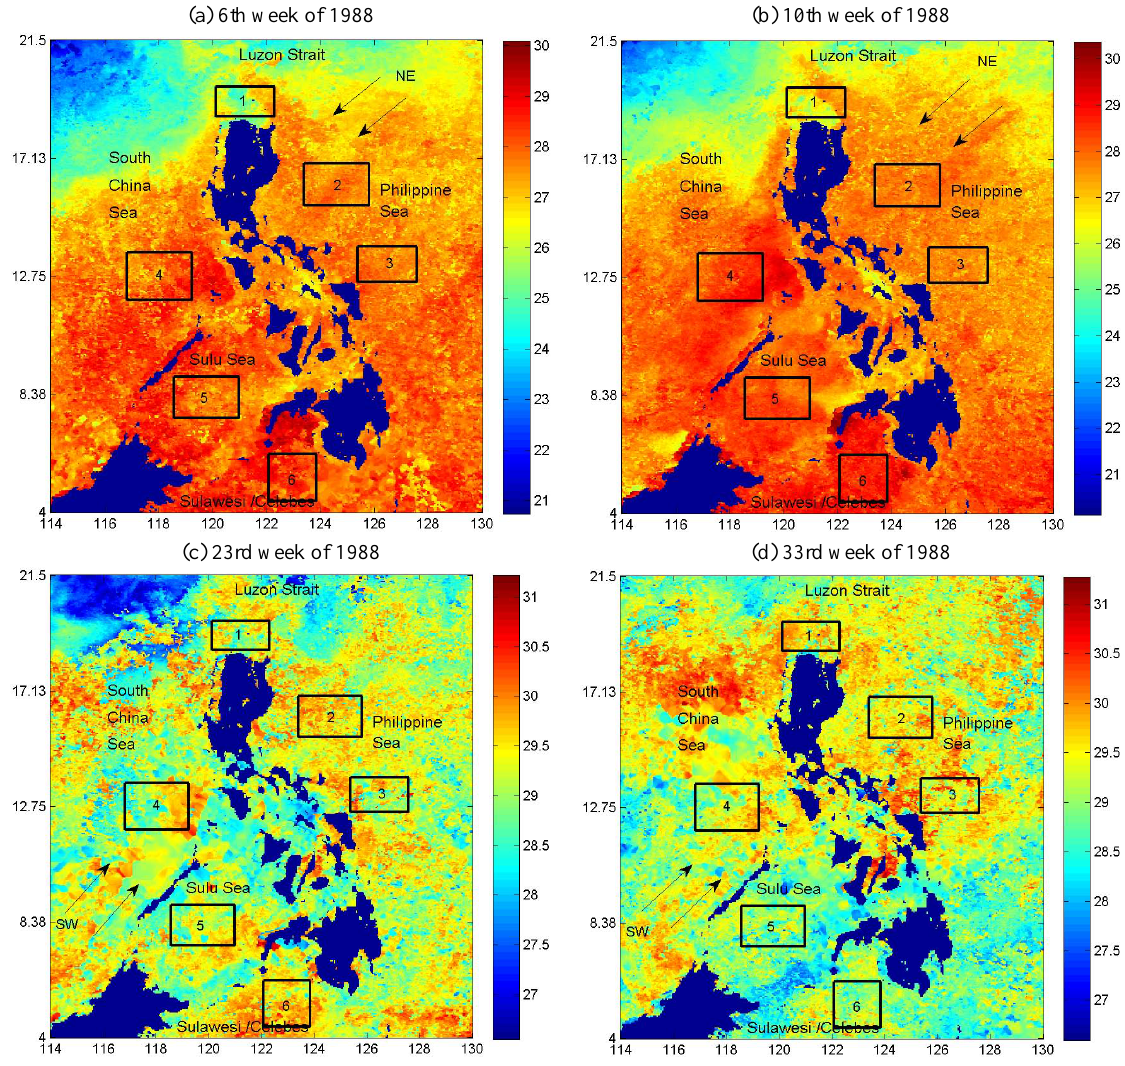
Fig. 2. SST during the NE monsoon season ( a and b ) and SW monsoon ( c and d ). The arrows indicate the direction of the prevailing winds (not scaled to indicate wind strength). The locations of the six thermal regions are indicated in